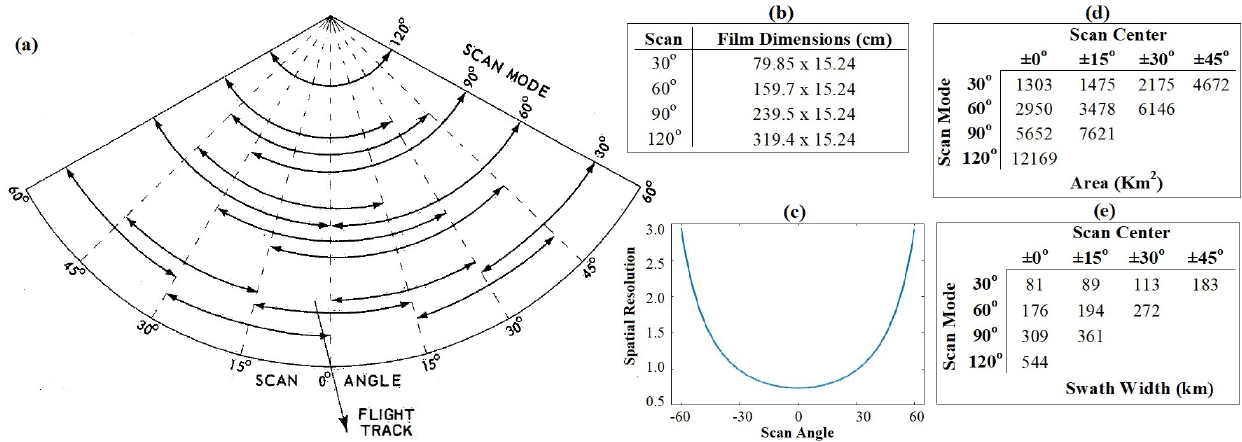
Figure 1. (a) The KH-9PC-acquired images at four different scan angles, i.e., 30, 60, 90 and 120 ◦ , along with different scan centers, i.e., ± 0, ± 15 and ± 30 ◦ . (b) Film dimensions for each scan angle range. (c) Spatial resolution vs. scan angle with scan center at 0 ◦ . (d, e) The area and swath width of the ground footprint for each combination of scan angle and scan center (modified from NRO,